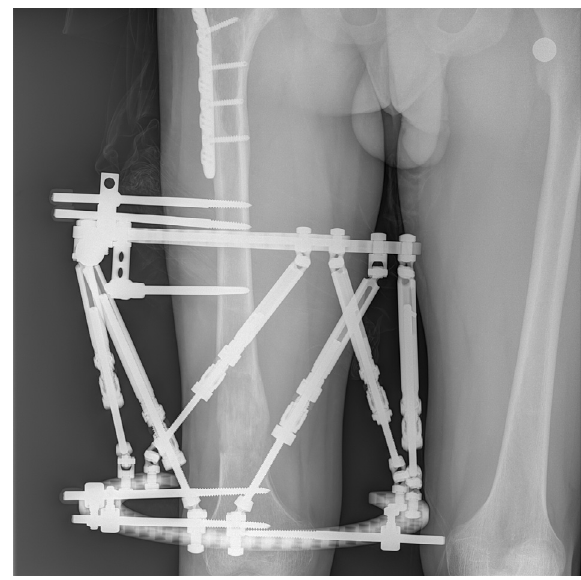
Figure 4. Same patient after correction with the Spider Frame (Case No. 5 in Table